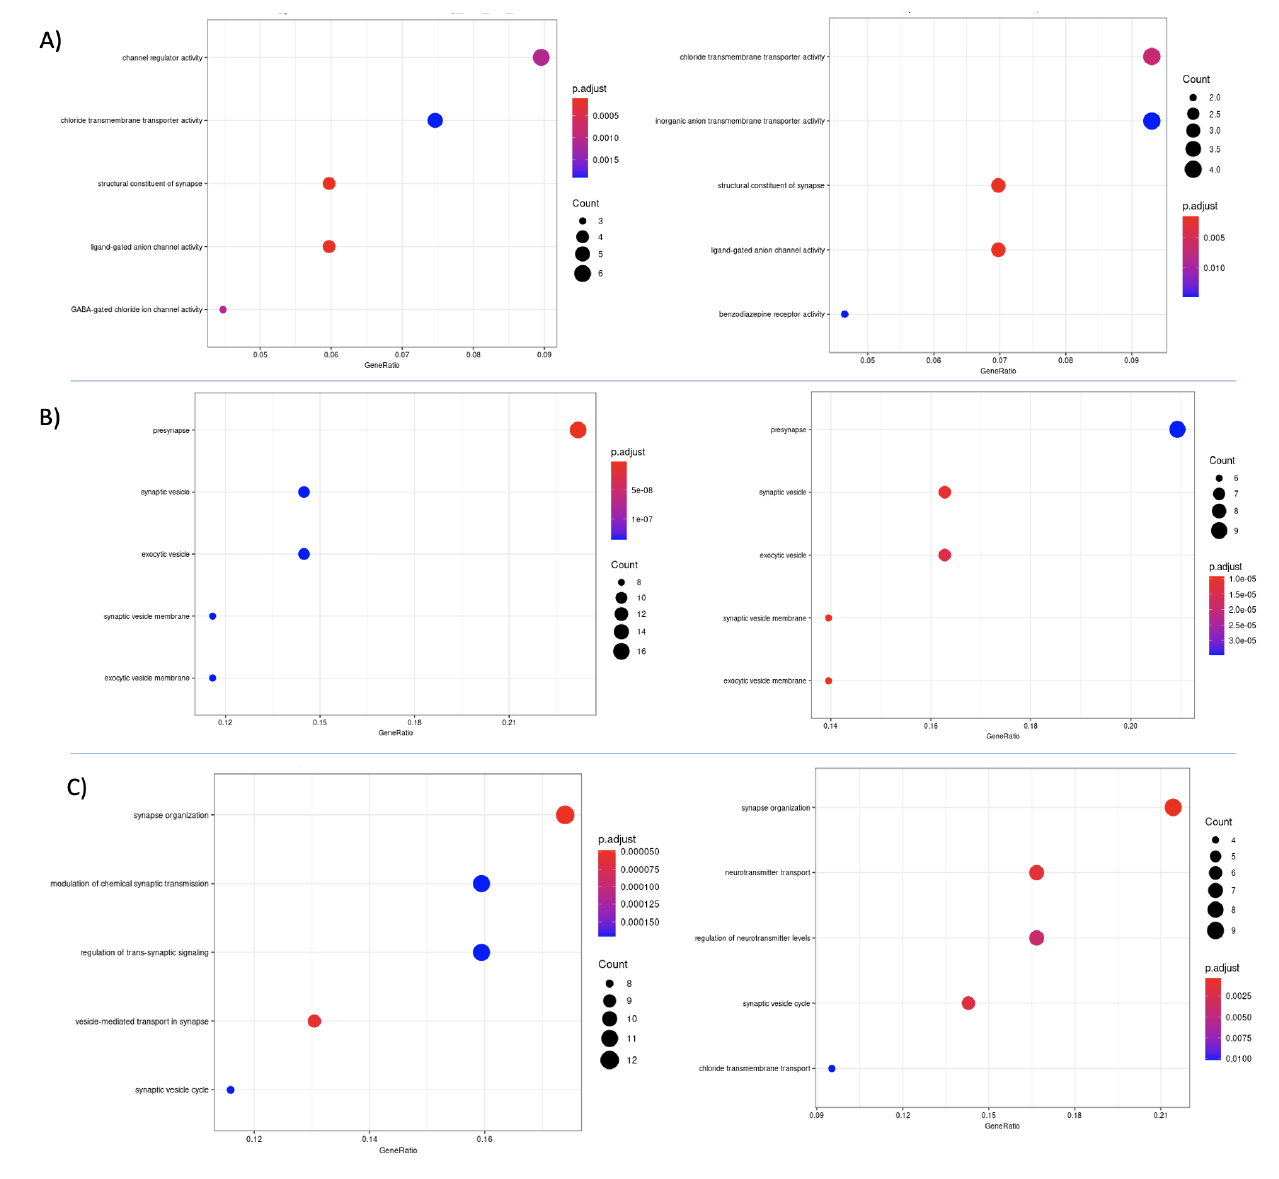
Figure 7. GO analysis was performed on the differentially expressed genes identified in the Denoising and Sparse autoencoders’ results in patients cluster 1 using the k-means algorithm. The GO results were used to analyze the ( A ) molecular functions, ( B ) Cellular components, and ( C ) Biological processes, identified by the Denoising Autoencoder and the Sparse Autoencoder